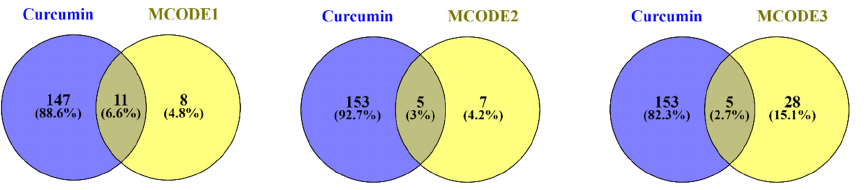
Figure 5. Intersection analysis to determine shared proteins between curcumin and the clusters of PPI network-related genes to diabetes based on MCODEs analysis.